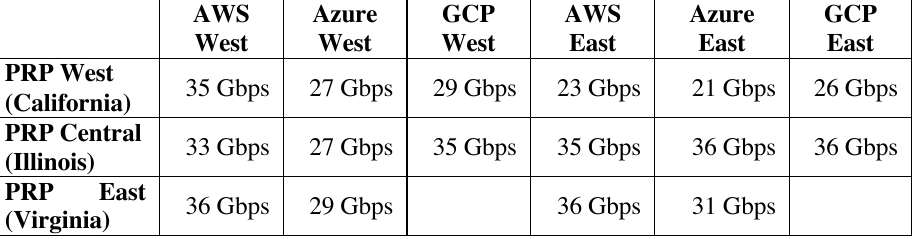
Table 2. Observed peak throughput while downloading data from Cloud-managed object storage